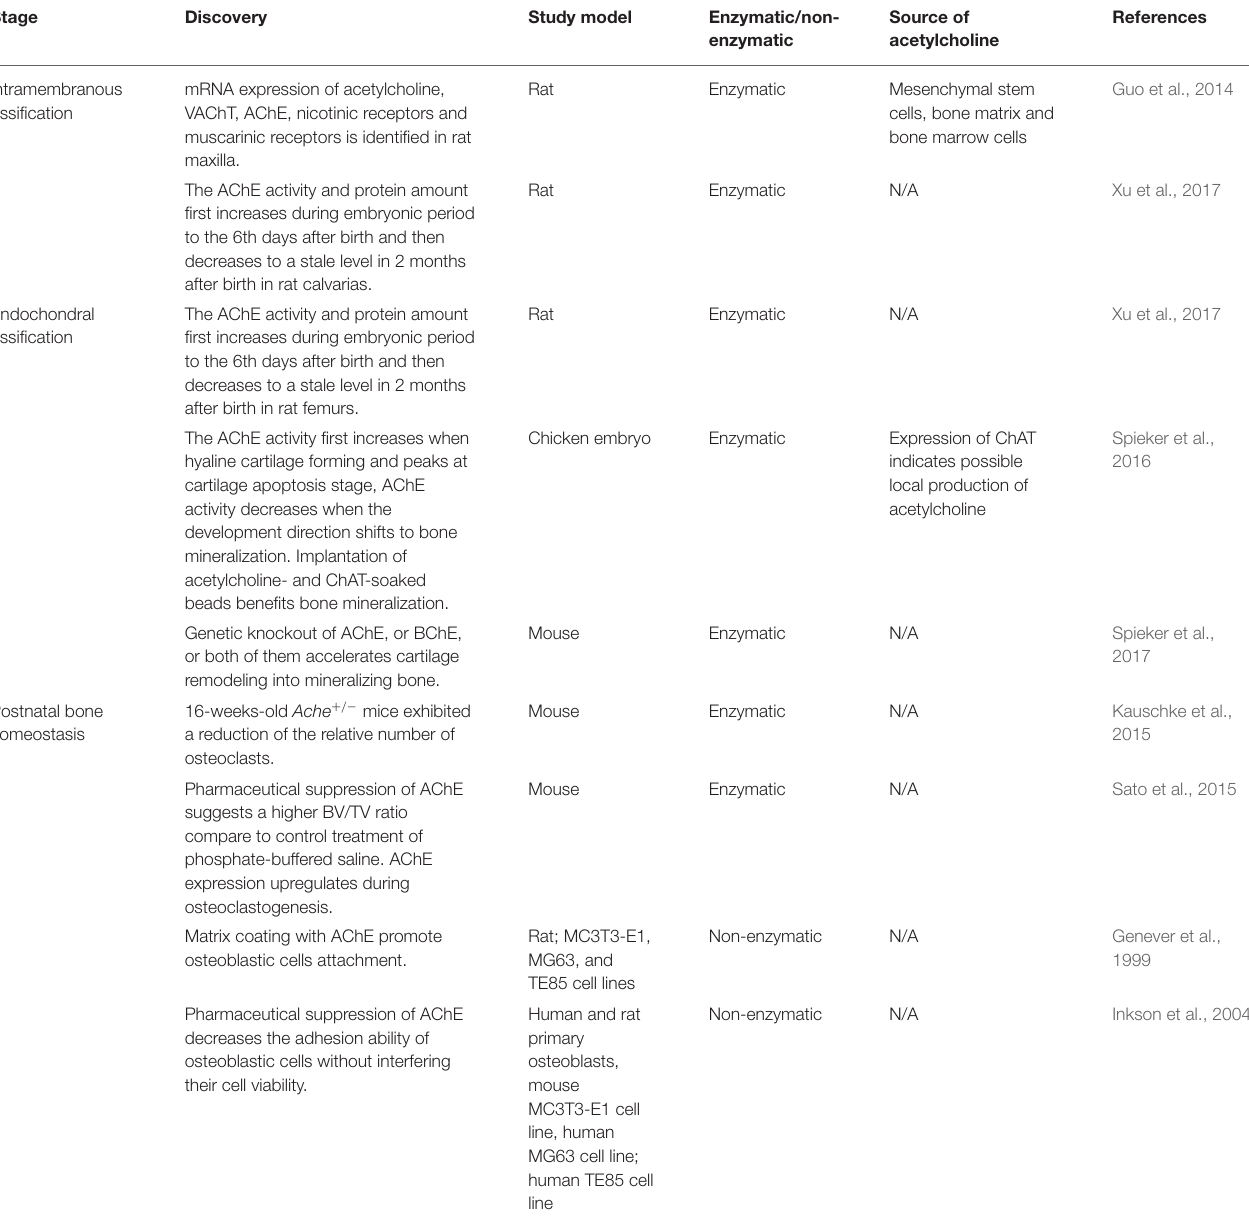
TABLE 2 | Function of AChE during bone development and